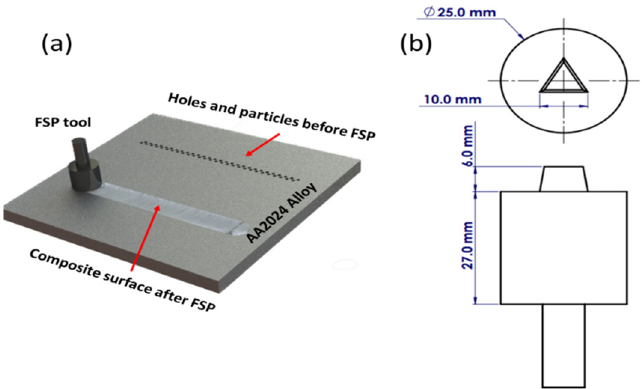
Figure 1. ( a ) Typical fabrication process of the nanocomposite surface using the friction stir process (FSP), and ( b ) design of the FSP tool.